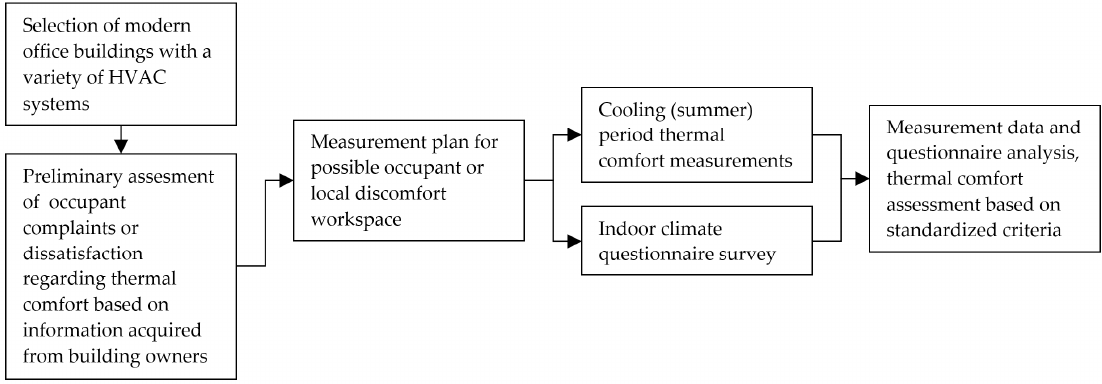
Figure 1. Flow chart of research methodology.